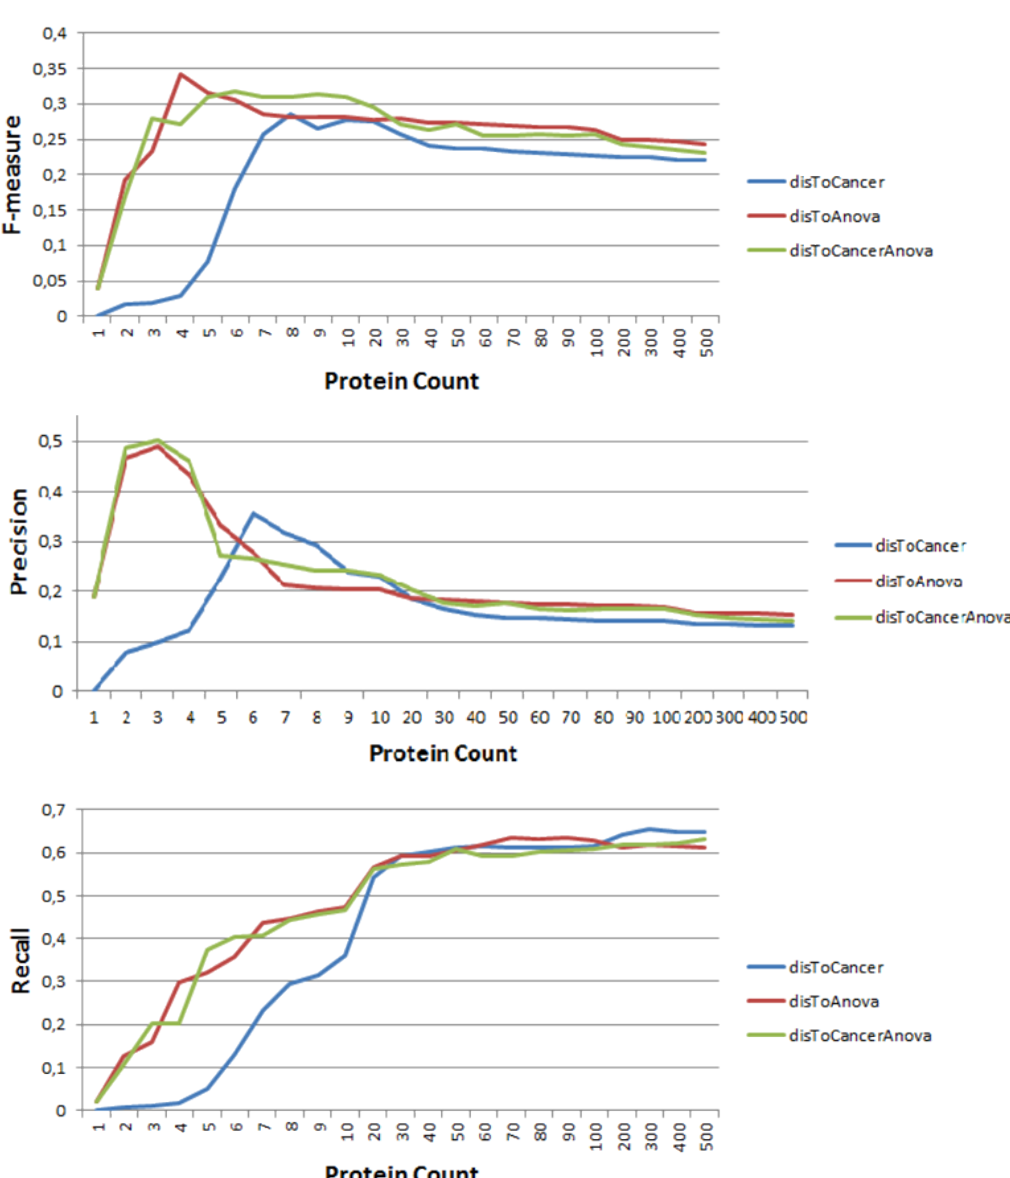
Figure 3: Comparing different Structural Context methods. With respect to F-measure, methods using ANOVA for selecting the important proteins almost always outperform the method which selects the previously known cancer-related